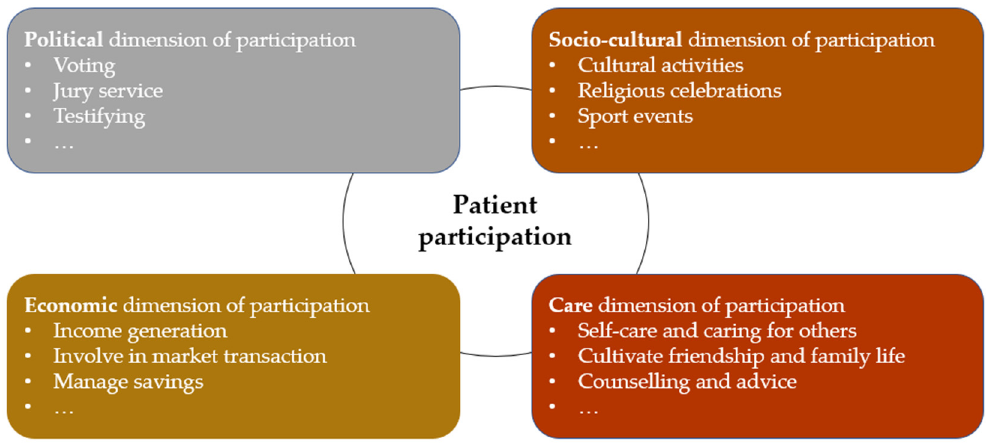
Figure 3. Four dimensions of participation often limited by mobility